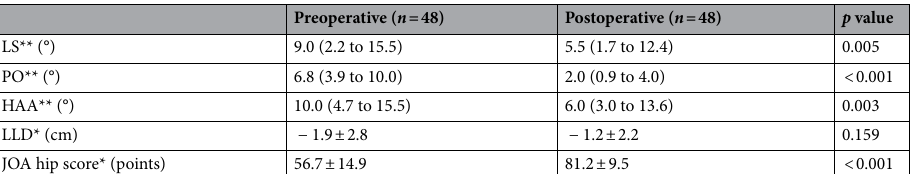
Table 2. A comparison of the absolute values of preoperative and postoperative coronal lumbar-pelvic- femoral alignment and of the preoperative and postoperative JOA hip scores. LS , lumbar scoliosis; PO , pelvic obliquity; HAA , hip adduction angle. JOA , Japanese Orthopaedic Association. *Values are the mean ± standard deviation and were compared using a paired samples t -test. **Values are the median (interquartile range) and were compared using the Wilcoxon signed-rank